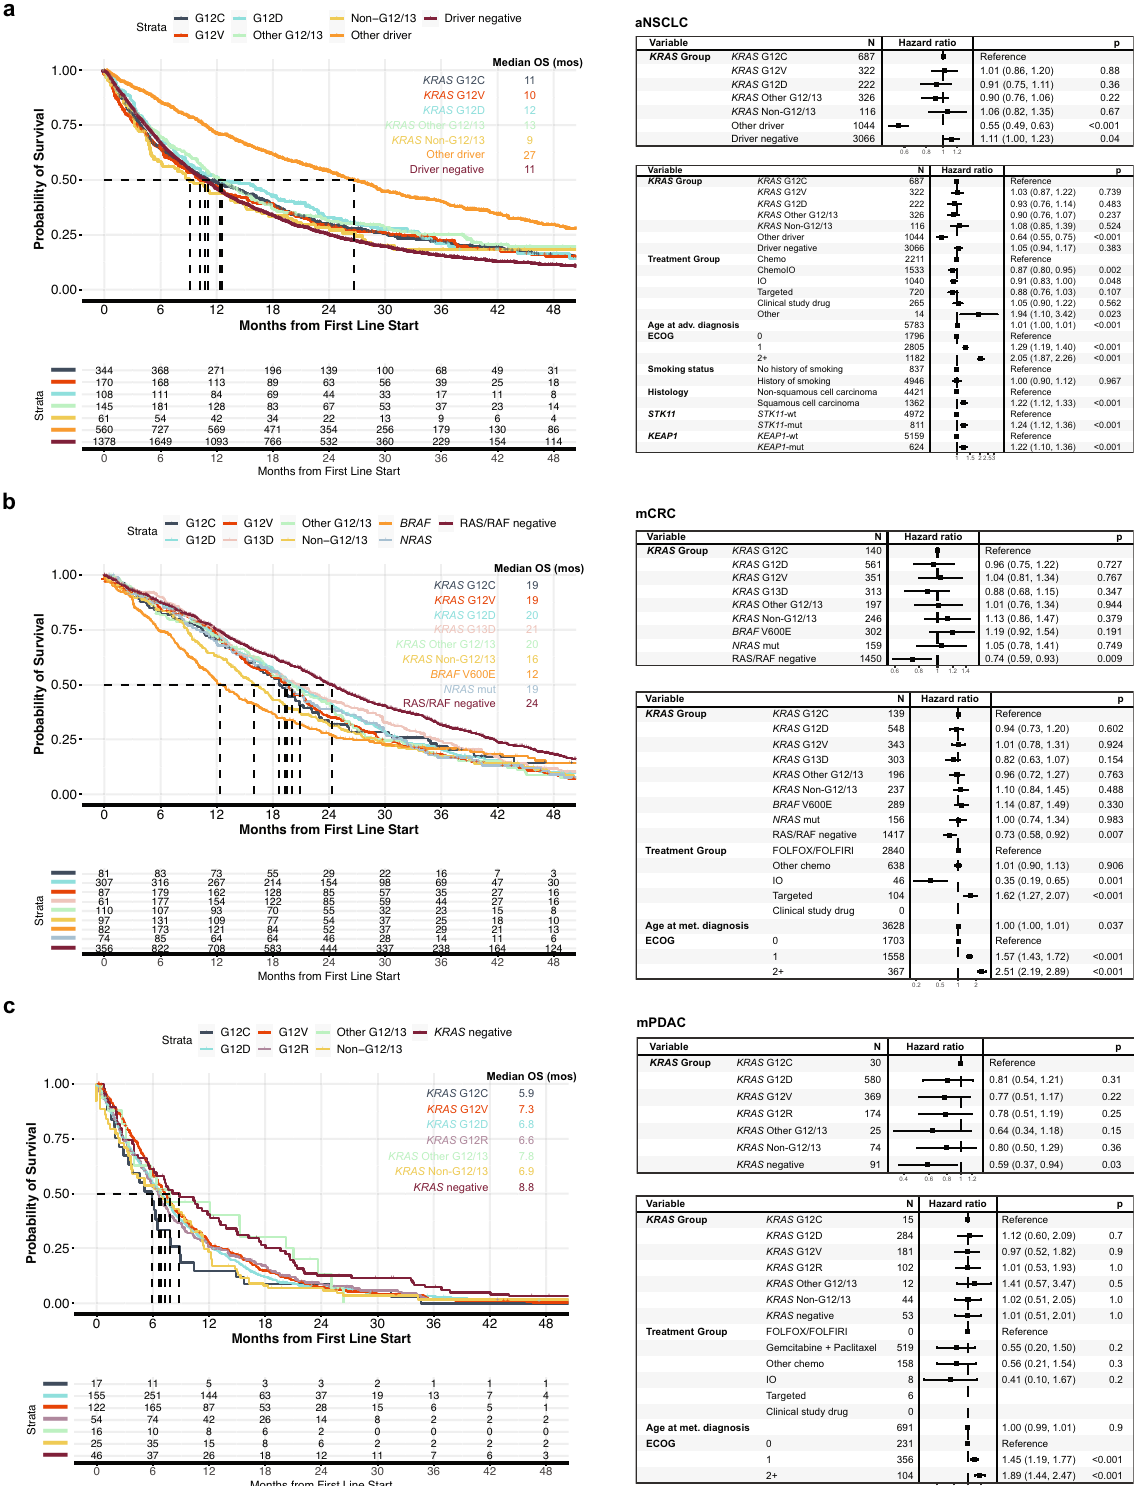
Fig. 5 Real-world outcomes for patients with NSCLC, PDAC, and CRC carrying different oncodriver alterations. Kaplan Meier curves for real world overall survival (rwOS) are shown with univariate (top) and multivariate (bottom) analysis tables for each disease subtype. Analysis was performed using the Flatiron Health-Foundation Medicine real-world clinicogenomic database. Patients with multiple driver alterations spanning >1 category were excluded. a In patients with advanced NSCLC harboring KRAS G12C mutant tumors have similar rwOS to other KRAS G12/13, KRAS non-G12/G13C, and driver negative patients. b In metastatic CRC, patients with KRAS G12C had similar rwOS compared to other KRAS mutant isoforms, BRAF V600E, and NRAS mutations, but worse rwOS compared to patients negative for KRAS and NRAS mutations and BRAF V600E ( RAS/RAF negative). c In metastatic PDAC, rwOS was marginally inferior for KRAS G12C vs KRAS WT, although the differences were small and were not observed in the multivariable